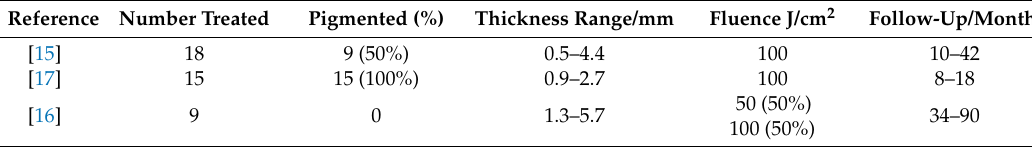
Table 1. Tumour characteristics and treatment parameters.